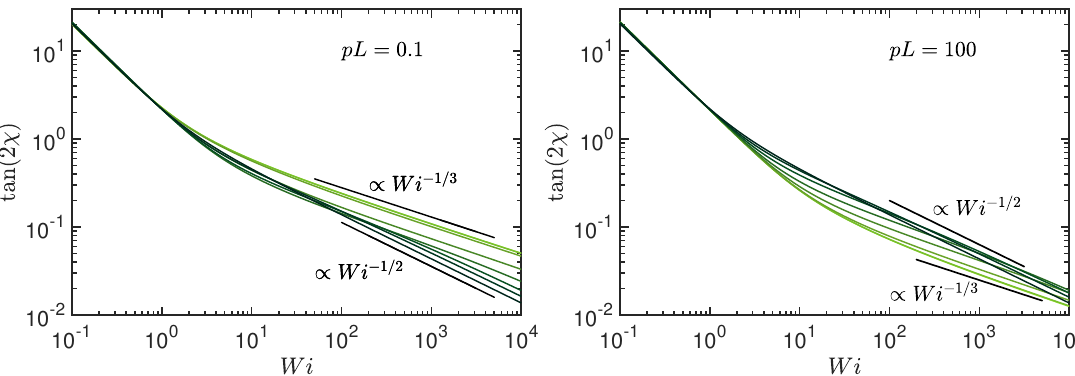
Figure 8. Shear-induced polymer alignment, characterized by the angle χ G between the eigenvector of the gyration tensor with the largest eigenvalue and the flow direction, as function of the Weissenberg number Wi . The Péclet numbers are Pe = 0, 0.6, 3, 10, 30, 10 2 ,3 × 10 2 , and ∞ (bright to dark color); ( left ) pL = 0.1 and ( right ) pL = 10 2 . The number of active sites is L / l = 10 2 and ∆ =